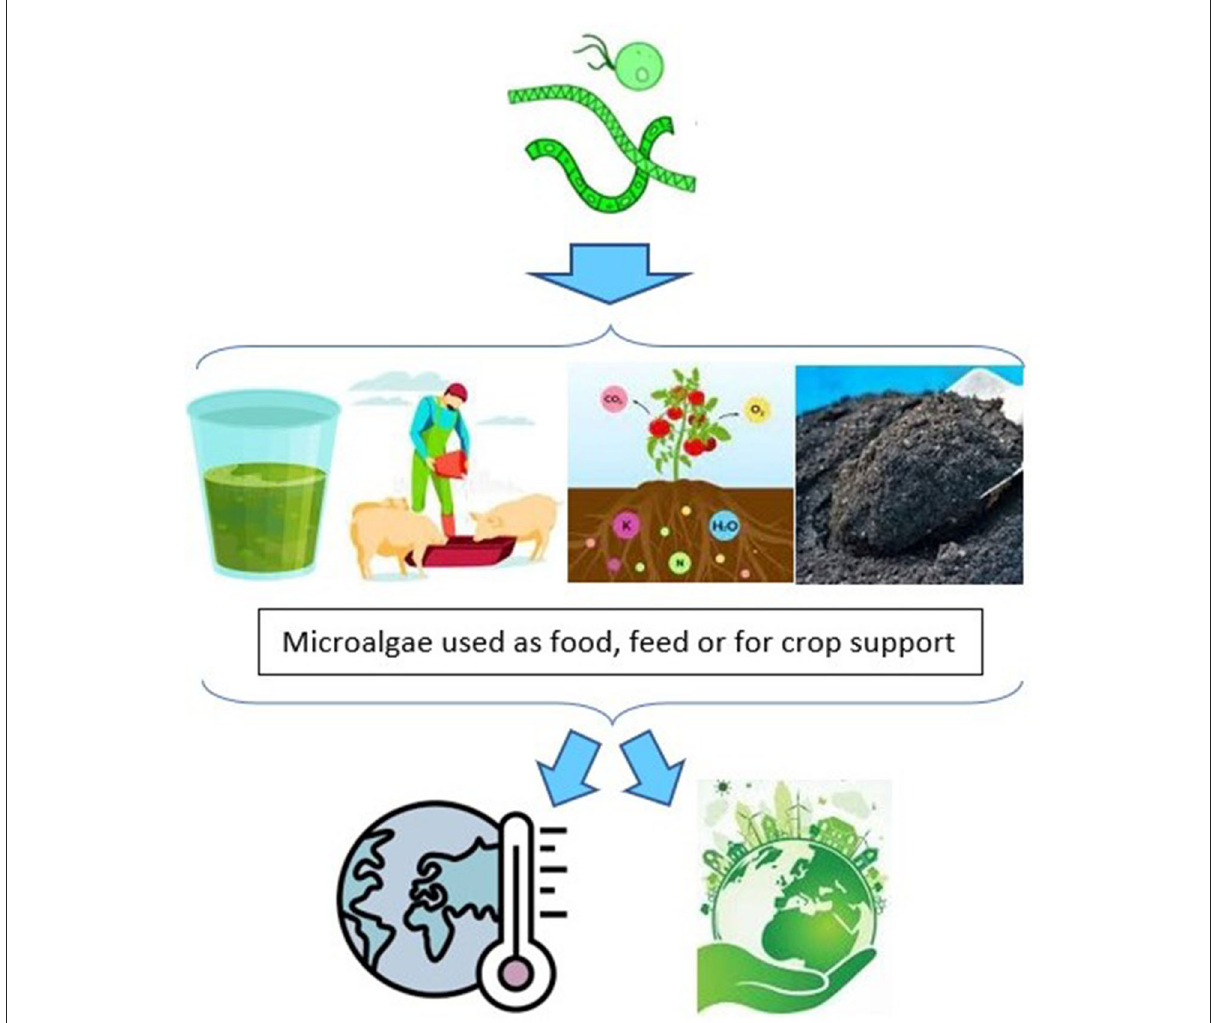
FIGURE1 Agri-food applications of microalgae can potentially contribute to CC mitigation and/or CC adaptation objectives.